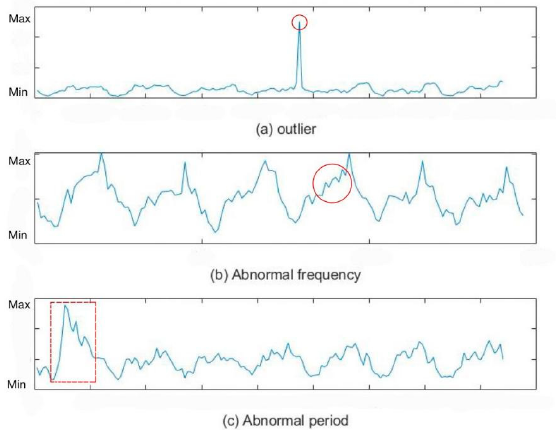
Figure 1. View of various exceptions about KPI.